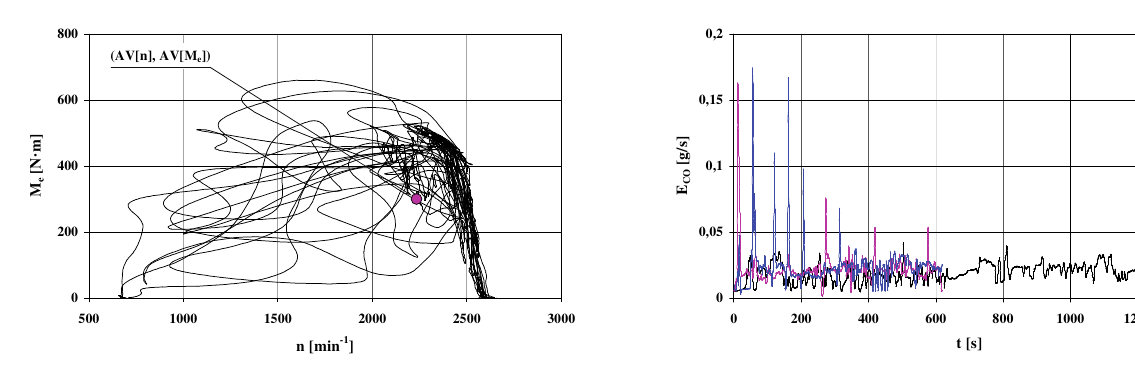
Fig. 11. Courses of the carbon monoxide emission intensity – E CO in tests